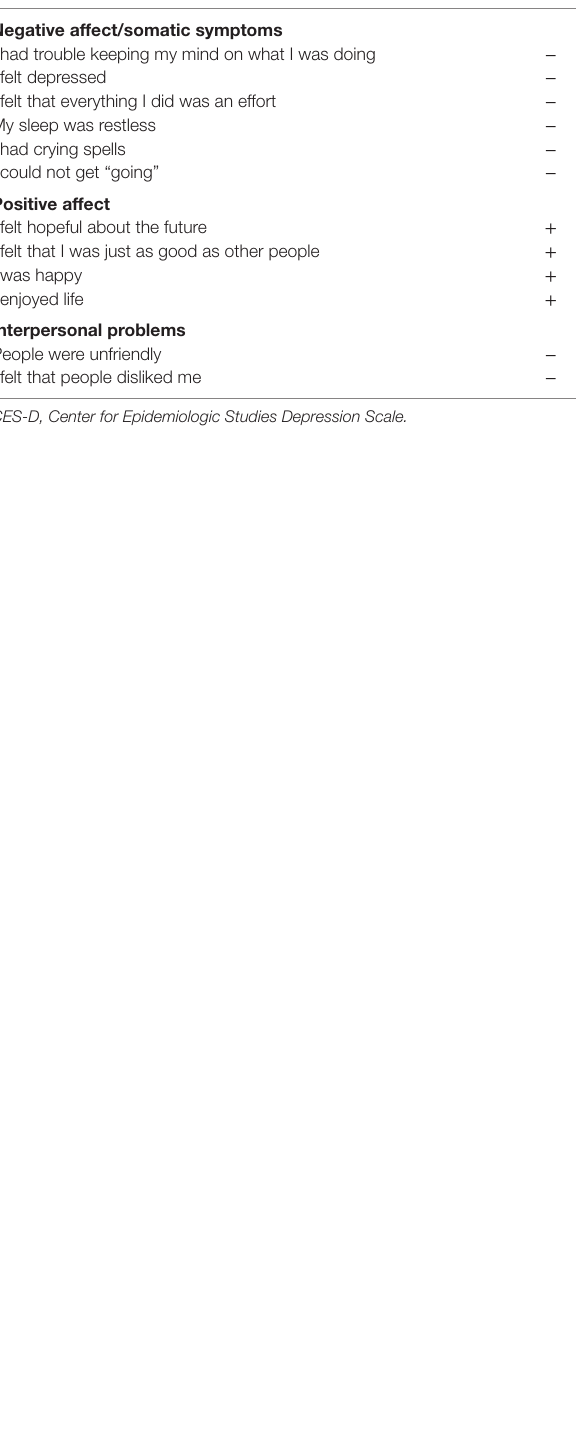
TaBle a1 | Factors of the 12-item center for epidemiologic studies Depression (ces-D) scale.